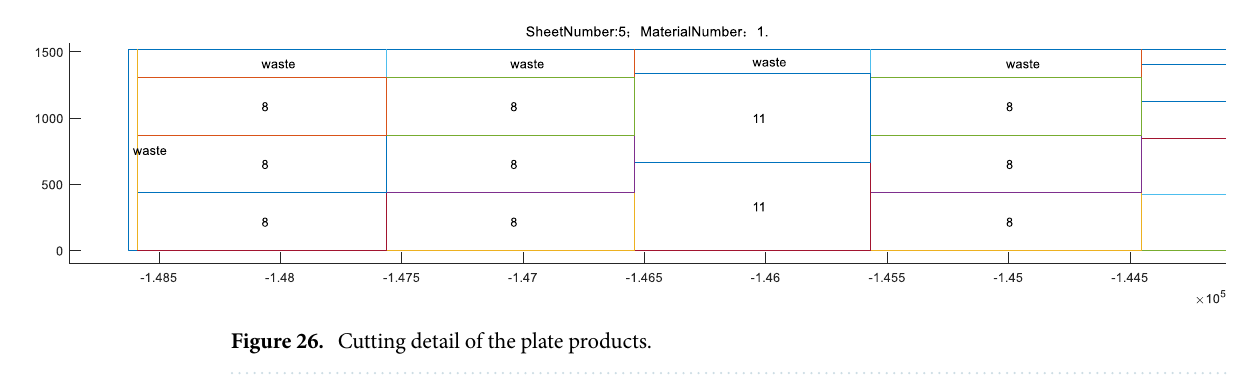
Figure 25. Rectangular packing result chart.